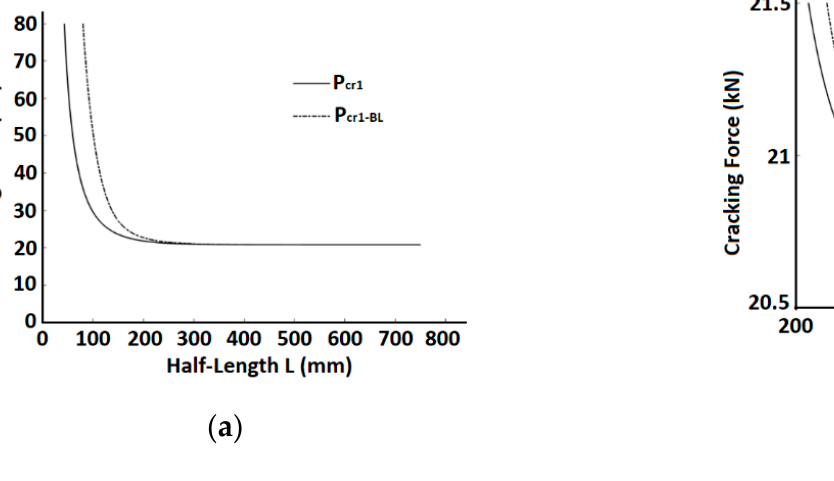
Figure 7. Dependence of cracking forces for linear [18] and bi-linear models on the bar length. ( a ) The entire range of half-length L ; ( b ) Zoom at half-length L > 200 mm.